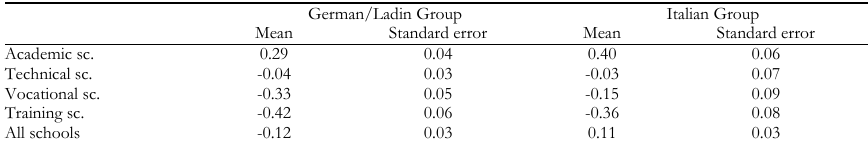
ESCS in Bolzano by school type and language group German/Ladin Group Italian Group Mean Standard